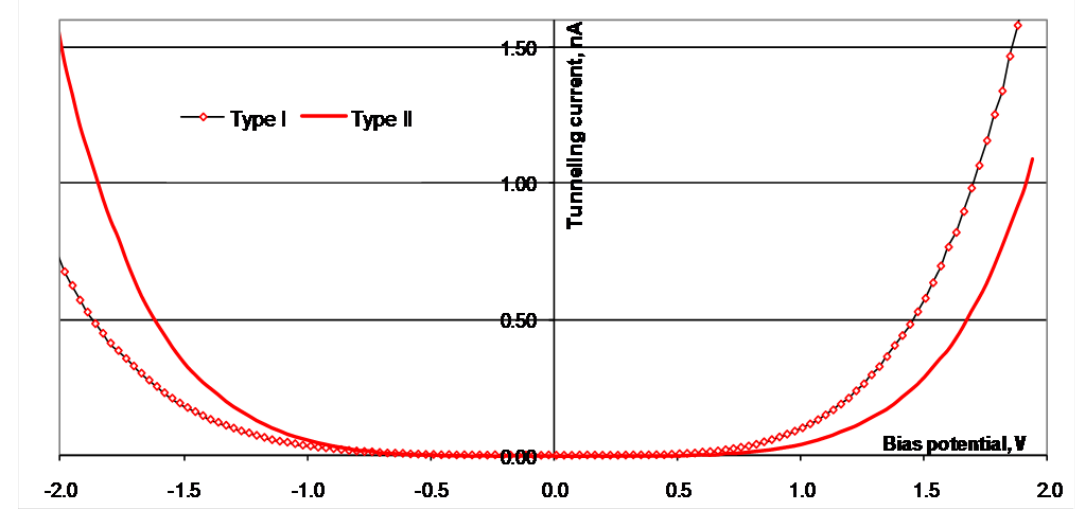
Figure 9. I(U) curves obtained from STS scans performed on the surface of Ni58Co20Si10B12. The absolute value of the tunneling current is used.